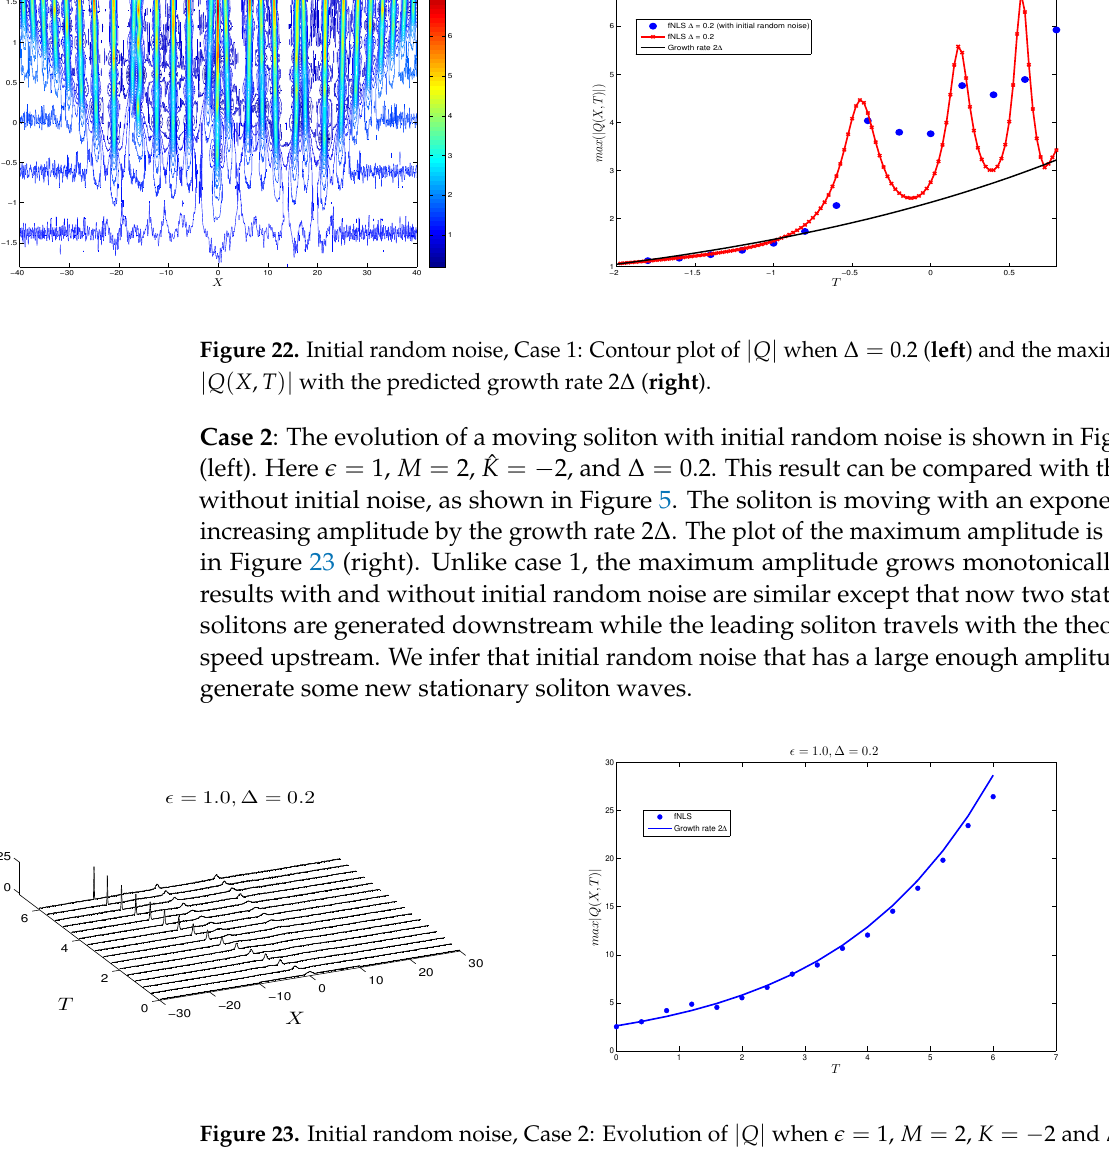
Figure 23. Initial random noise, Case 2: Evolution of | Q | when (cid:101) = 1, M = 2, K = − 2 and ∆ = 0.2 ( left ) and the maximum of | Q ( X , T ) | with the predicted growth rate 2 ∆ ( right